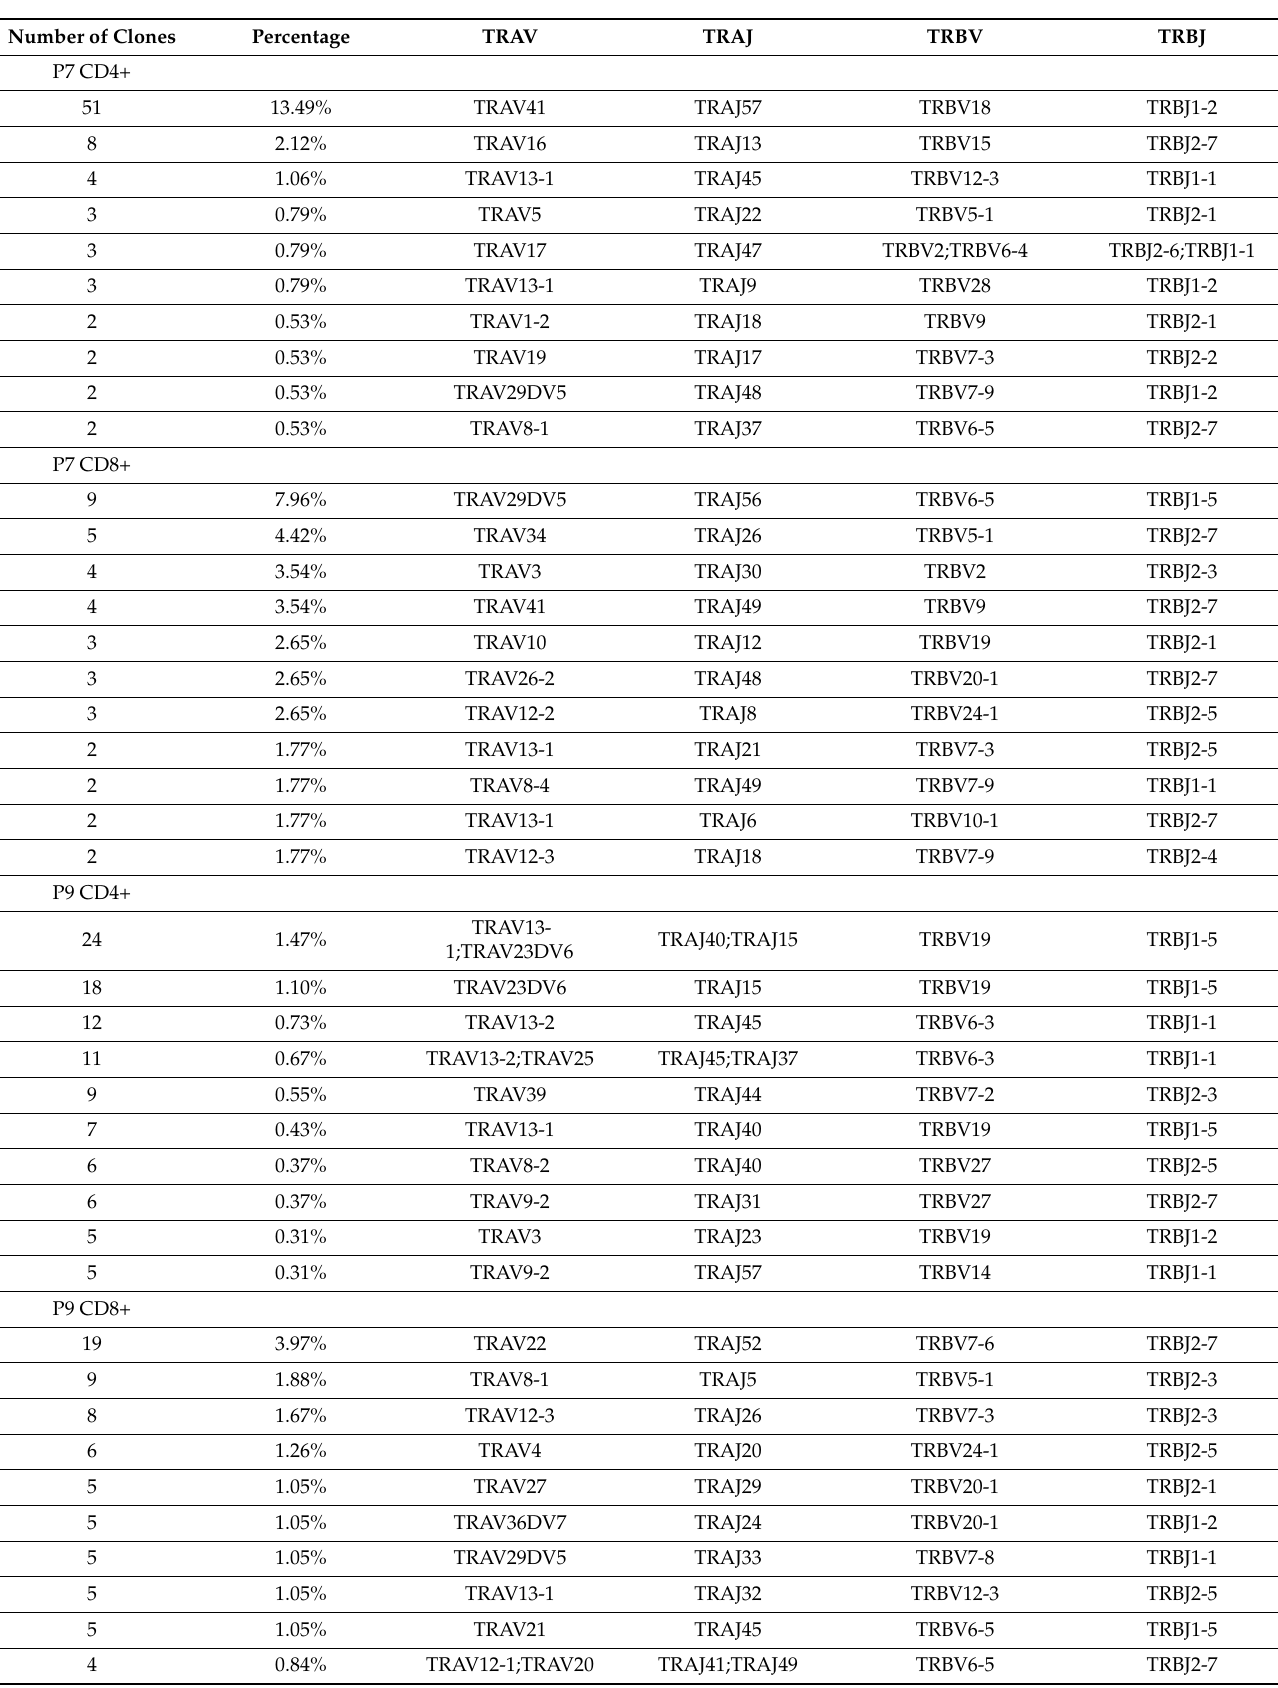
Table 2. Most frequent pairs of V-J usage